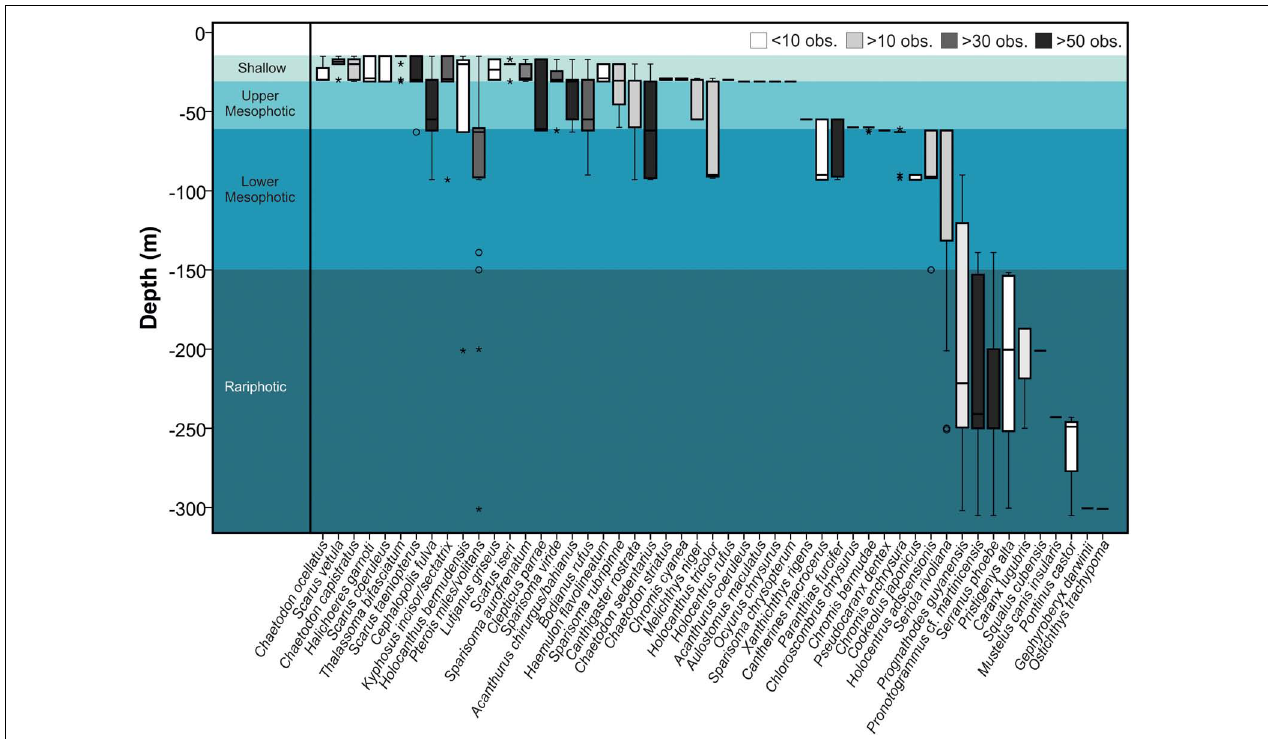
FIGURE 2 | Depth distributions of the 51 fish species recorded between 15 and 305 m off Bermuda. Boxes indicate the 25th and 75th quantiles, whiskers are 1.5 the interquartile, circles are outliers, and asterisks extreme